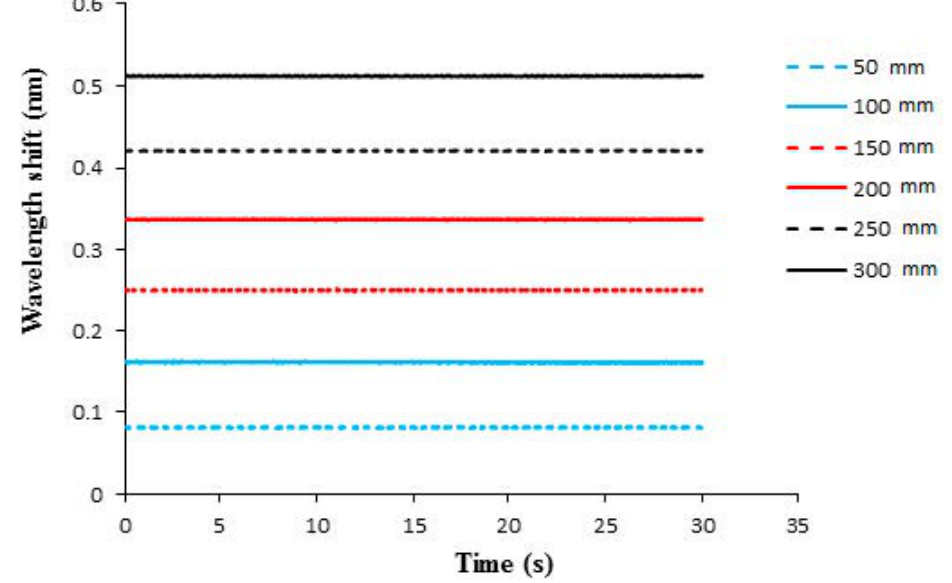
Figure 7. Bragg wavelength shift from the FBG sensor under various water levels with diaphragm thickness of 0.5 mm.